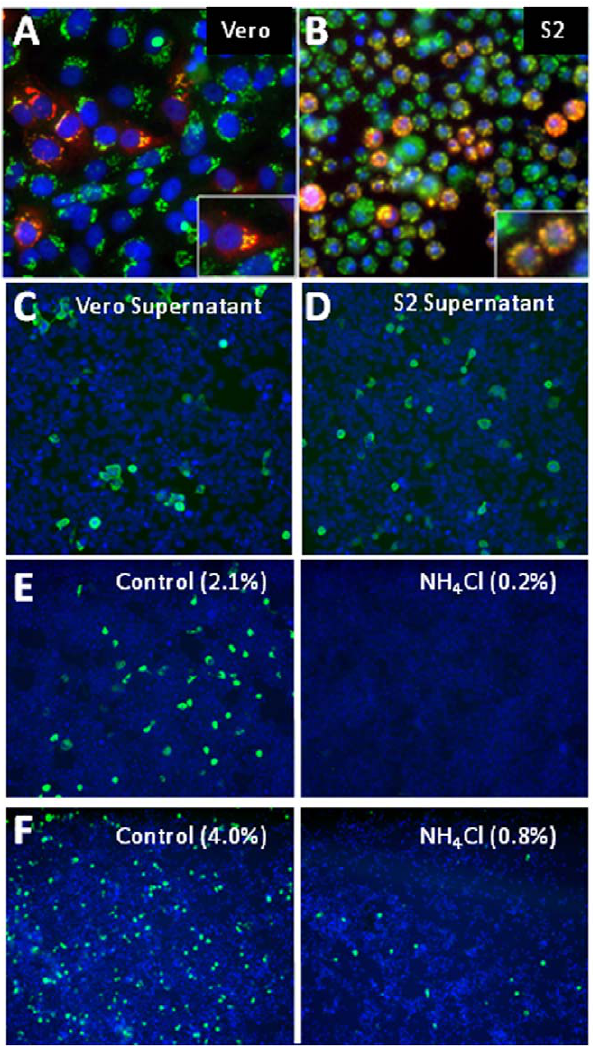
Figure 1. RVFV MP12 productively infects both human and Drosophila cells. A . Vero cells were infected at an MOI=0.08 for 15 hours and RVFV infection was detected by immunofluorescence using mouse anti-RVFV G c (red), anti-TGN46 (Golgi marker, green), and the nuclear dye DAPI (blue). Inset shown at higher magnification. B . Drosophila S2 cells were infected at an MOI=0.02 for 48 hours and RVFV infection was detected by indirect immunofluorescence using mouse anti-RVFV G N (red), anti-GM130 (Golgi marker, green), and the nuclear dye DAPI (blue). Inset shown at higher magnification. C–D . RVFV MP12 produced in Vero cells ( C ) or Drosophila S2 cells ( D ) was used to infect 293T/17 cells and detected by immunofluorescence with mouse monoclonal anti-RVFV N (green) and the nuclear dye DAPI (blue). E–F . Ammonium Chloride (NH 4 Cl; 960 m M) inhibits RVFV infection in mammalian 293T cells infected at an MOI of 0.1 for 15 hours ( E ) and Drosophila S2 cells ( F ) infected at an MOI of 0.1 for 48 hours. Infected cells were visualized by immunofluorescence against RVFV N (green) and counterstained with DAPI (blue).